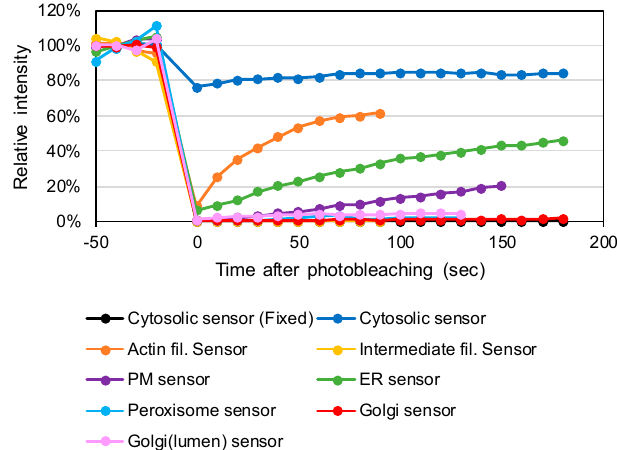
Figure 2. Fluorescence recovery after photobleaching (FRAP) confirmed effective anchoring of Grx1-roGFP2 to organelle membranes or cytoskeletons. To assess association to the cytoskeletons and organelle membranes, fluorescence recovery was monitored for 180 s after photobleaching. Original confocal images are shown in Supplementary Data 4. As non-diffusible controls, cells were fixed with 3.7% paraformaldehyde prior to FRAP (Grx1-roGFP2 Fixed).